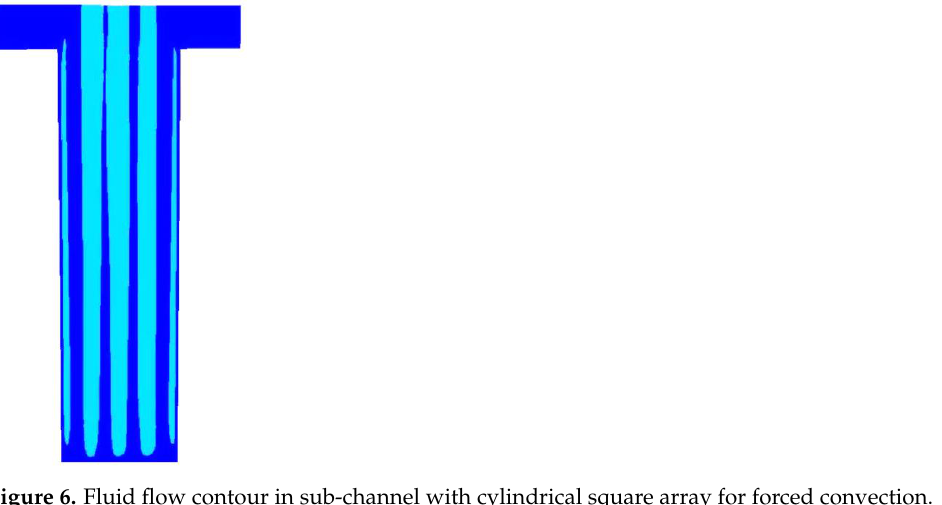
Figure 7. Velocity distribution on sub-channel with cylindrical longitude arrangement on forced convection for laminar flow regime under distributor wall.